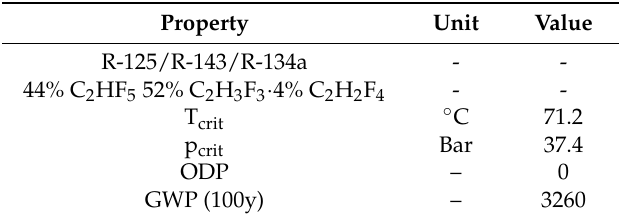
Table 1. Overview of the properties of R-404A. GWP: global warming potential .